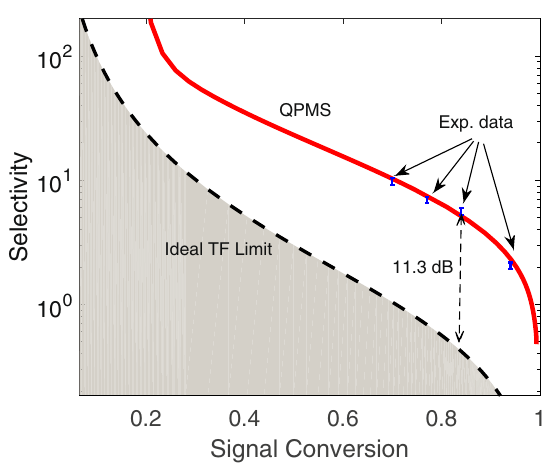
Figure 1. TF filtering versus QPMS. ( a ) and ( b ): Simplified schematics for a typical TF filter and a waveguide- based QPMS system, respectively; ( c ) The selection efficiencies of the first three signal modes { ζ i } for the TF filter in ( a ) and { η i } for QPMS system in ( b ), as a function of the time-bandwidth product.